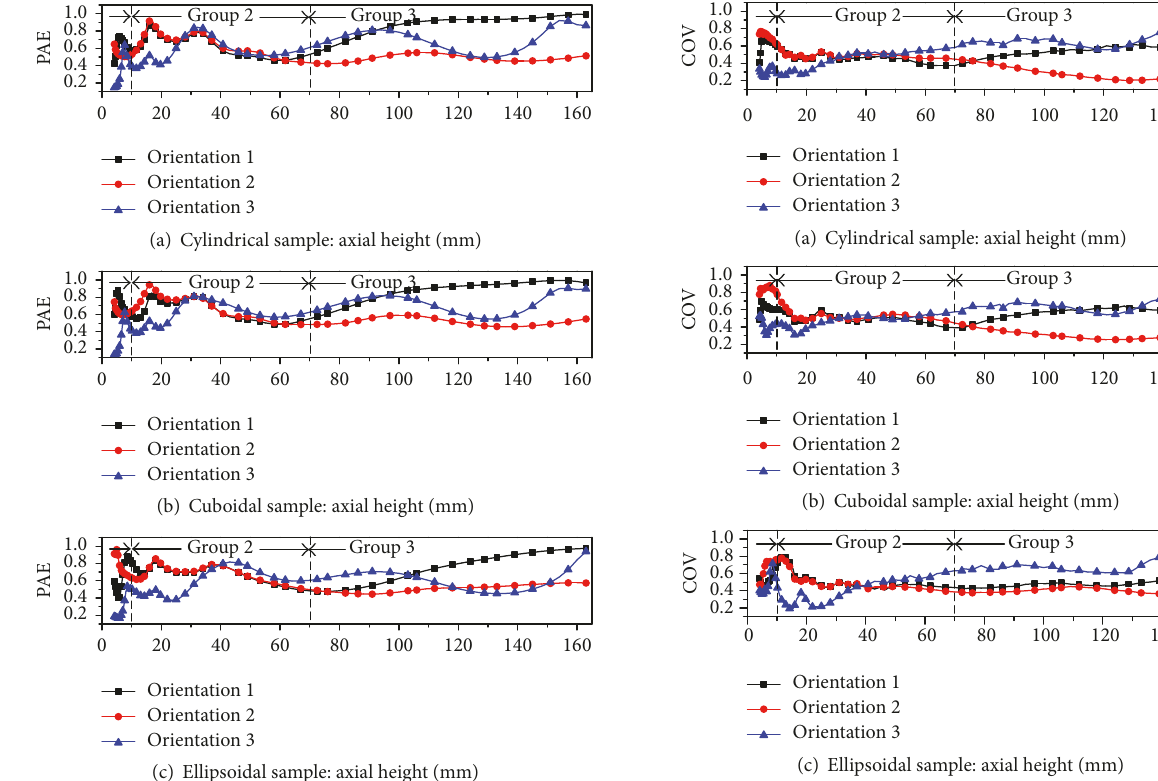
more flat, while those belonging to Group 3 are more slender.